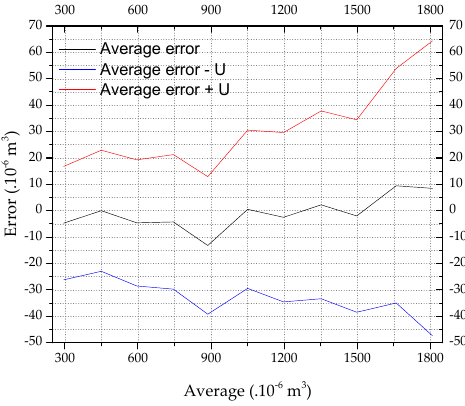
Figure 5. Error curve of the YF-S201 sensor.